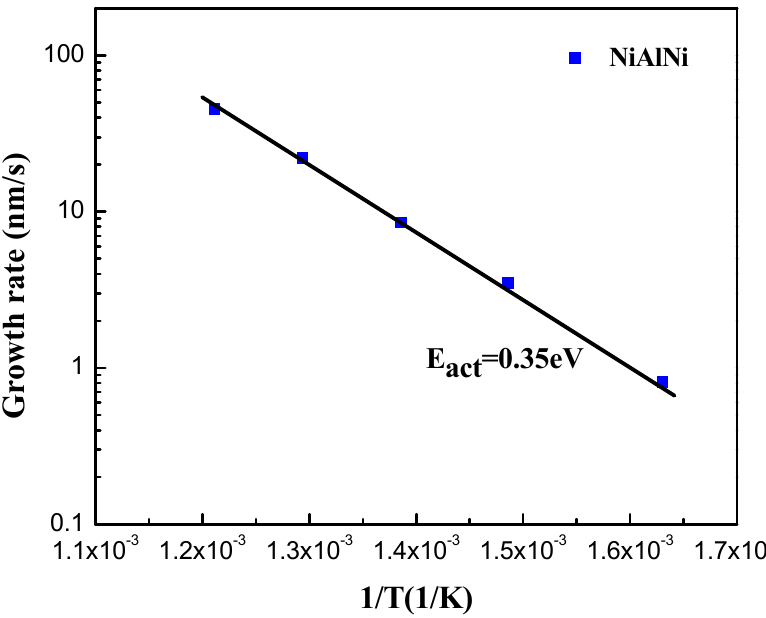
Figure 5. Arrhenius plot of growth rate versus inverse temperature of Ni–Al–Ni (1 nm–0.5 nm–1 nm) catalyst.